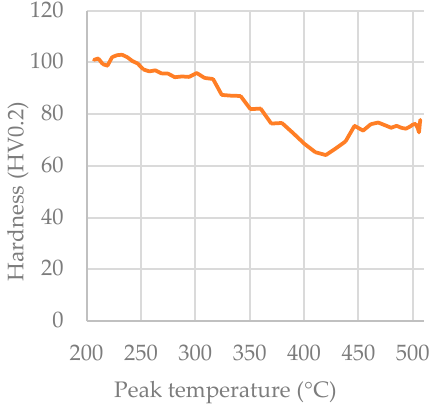
Figure 20. Hardness and peak temperature profiles relative to T510V5 test (T4 state).